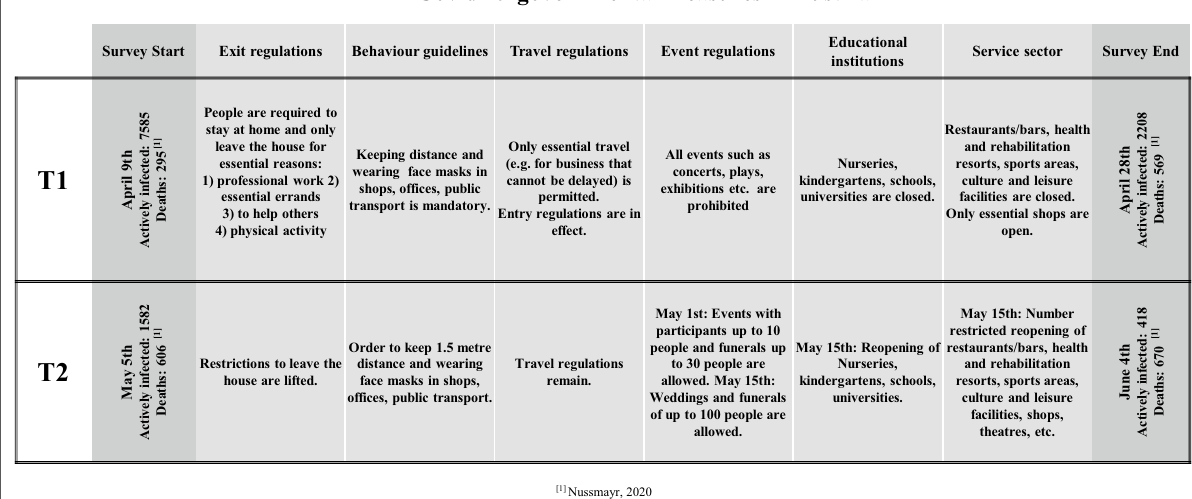
Fig.1 Overview of the COVID‑19 protective measures in Austria in April 2020 (T1) and May 2020